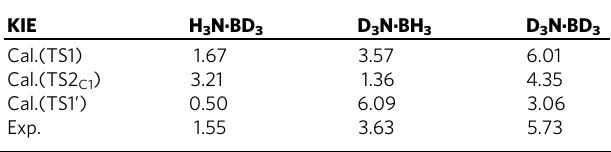
Table 1 Computational and experimental kinetic isotope effects.